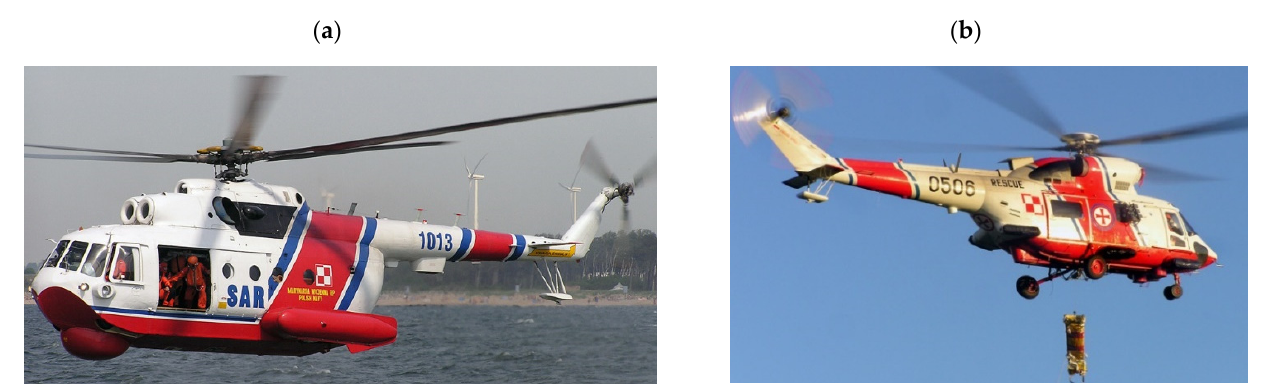
Figure 3. Types of helicopters equipped with the aviation SAR system: ( a ) Mi-14 PS, ( b ) W-3RM Anakonda.